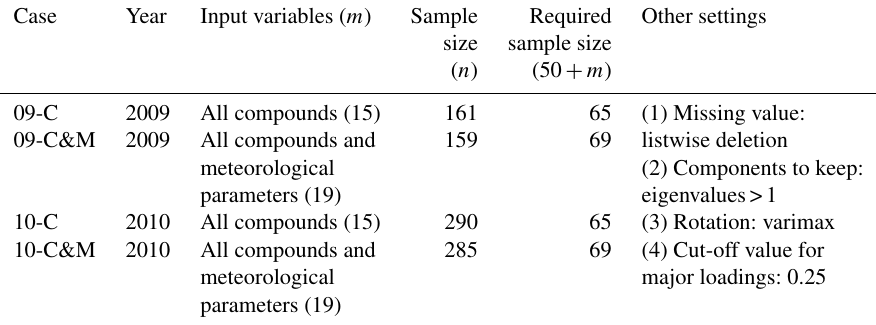
Table 4. PCA input and